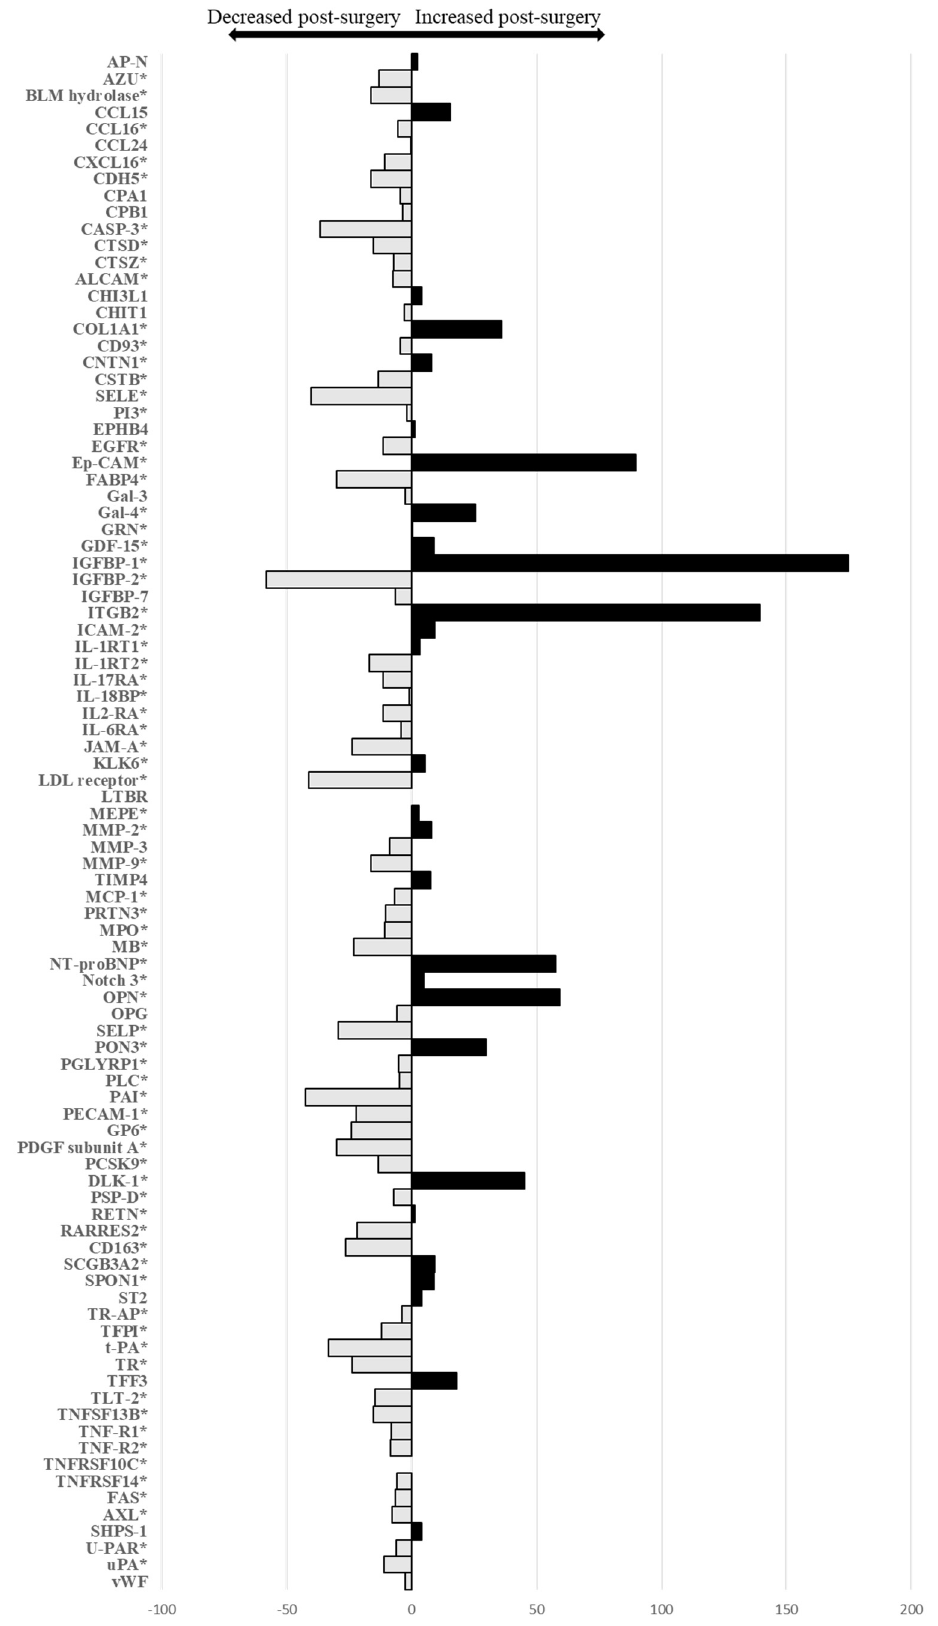
Figure 2. Graphical representation of the relative changes in all 92 biomarkers, pre- and post-bariatric surgery. * significant after Benjamini–Hochberg correction.